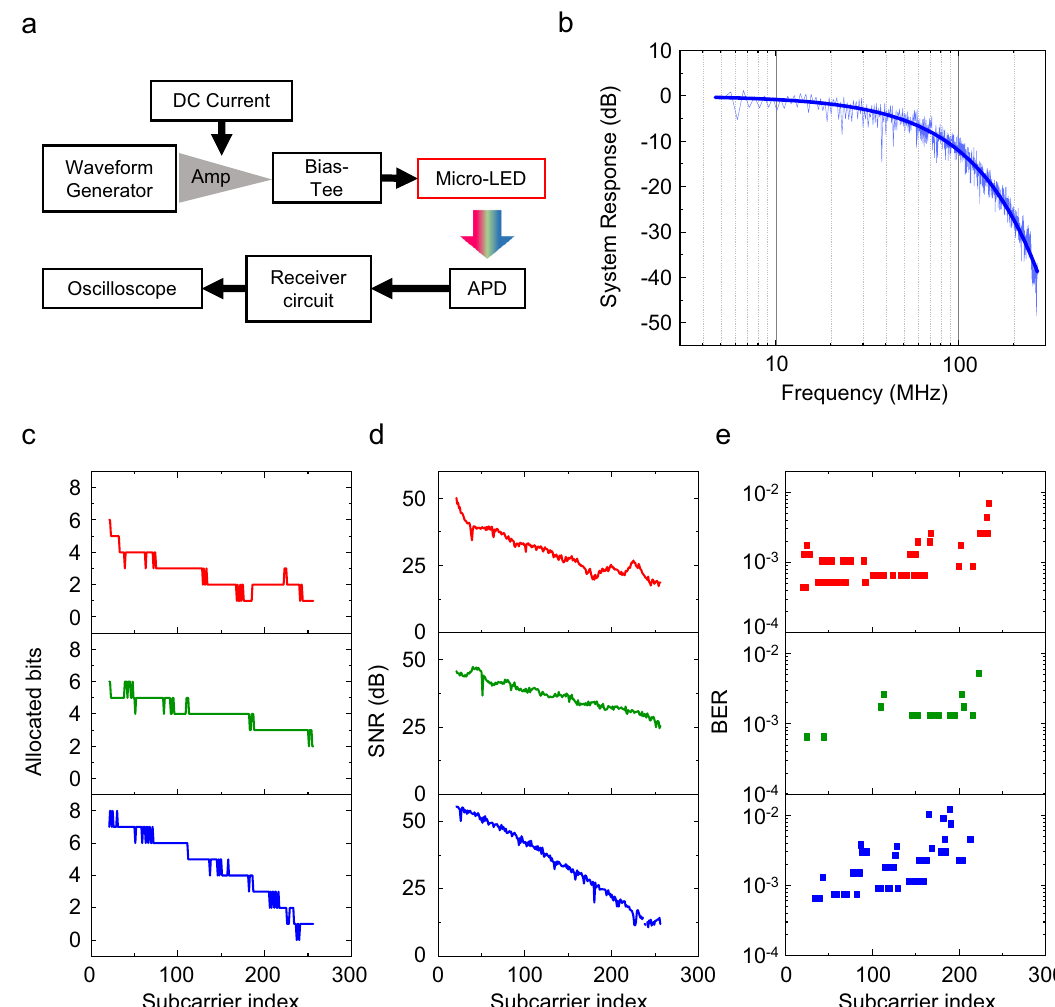
Fig. 5 OFDM-based WDM VLC application. a Flow chart of the experimental setup for 3-channel wireless visible light communication. b Frequency response of the blue micro-LED. c The adaptive bit loading for each subcarrier. Graphs showing the measured SNR ( d ) and BER ( e ) at different frequency